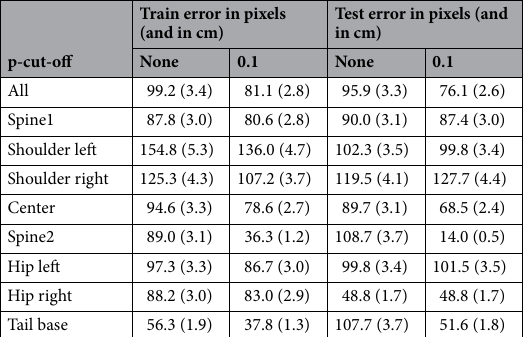
Table 2. DeepLabCut pose estimation prediction errors (in pixels) with or without probability cut-off (p-cut-off) values compared to the ground truth (manual annotations). For every DeepLabCut prediction, a likelihood is calculated and a p-cut-off can be defined to filter unreliable predictions. One cm was estimated to be equivalent to 29.1